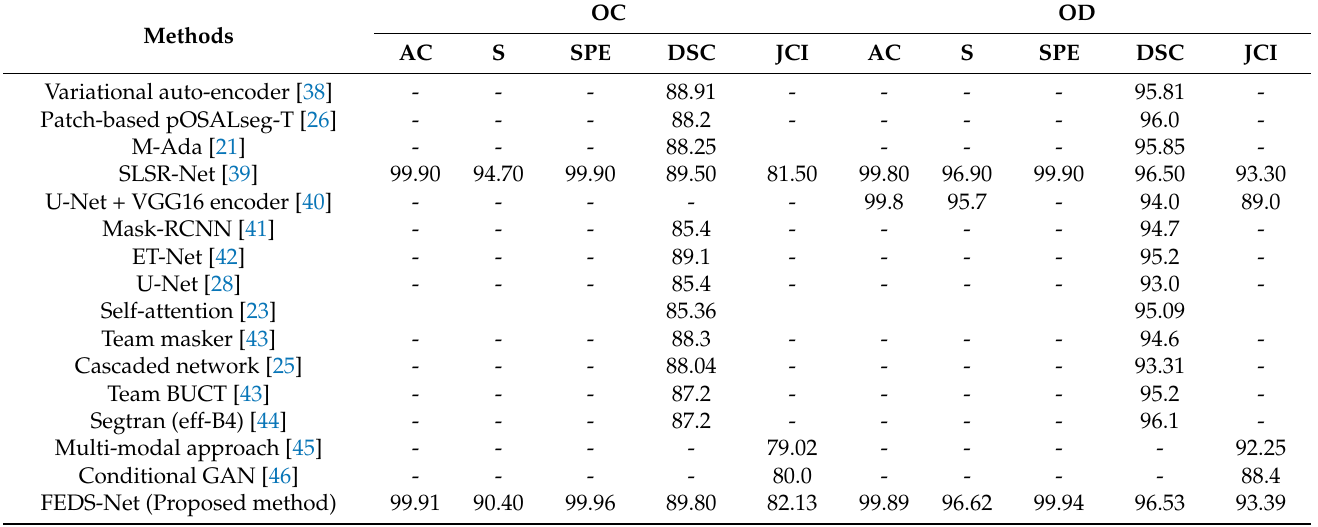
Table 1. Segmentation quantitative results comparison of FEDS-Net with state-of-the-art methods using the REFUGE database. “-“ indicates that no result is available (unit: %). (OC: optic cup; OD: optic disc; AC: accuracy; S: sensitivity; SPE: specificity; DSC: dice similarity coefficient;